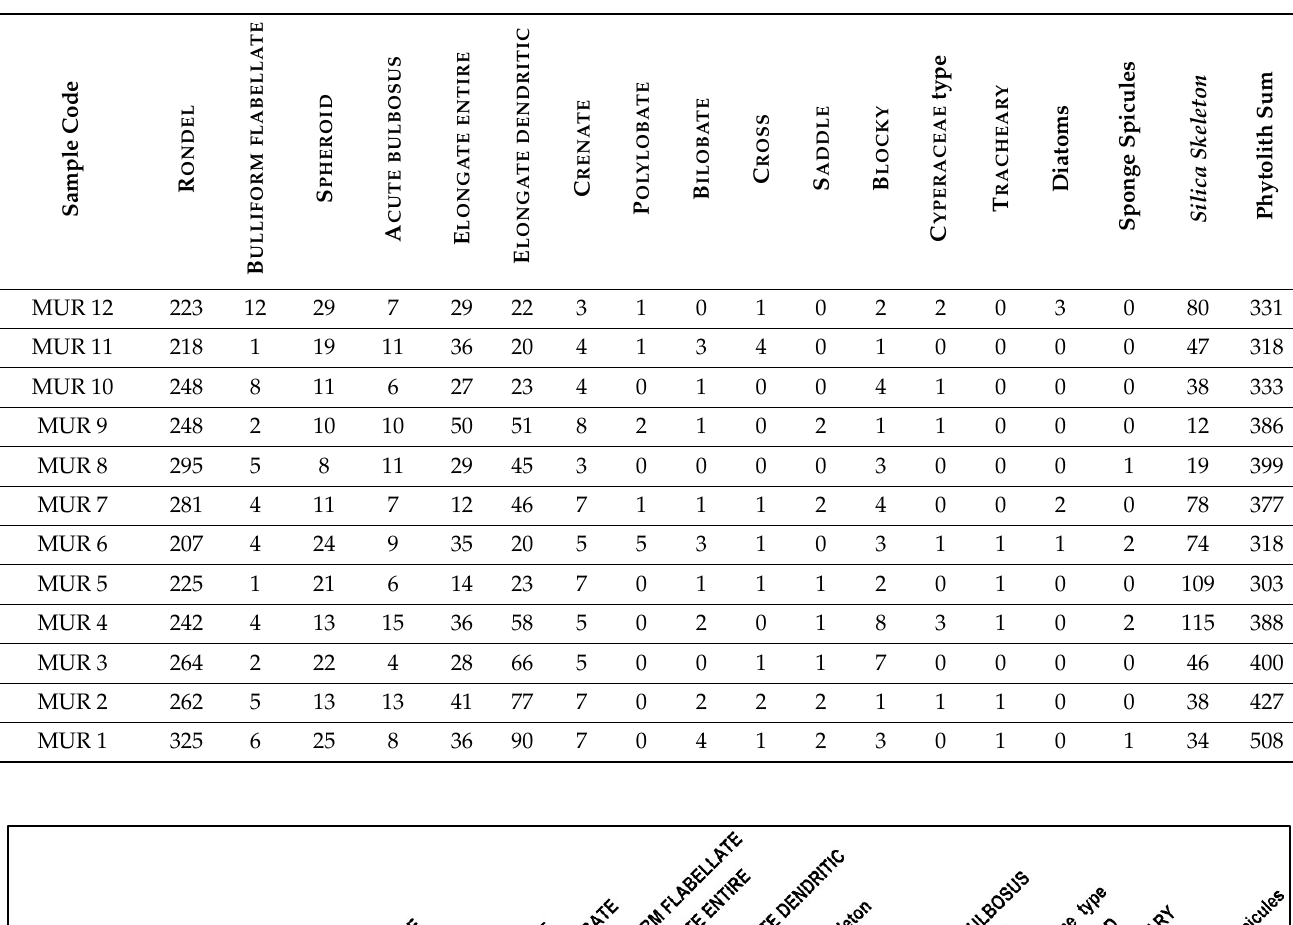
Table 1. Phytolith data from Halmyris.